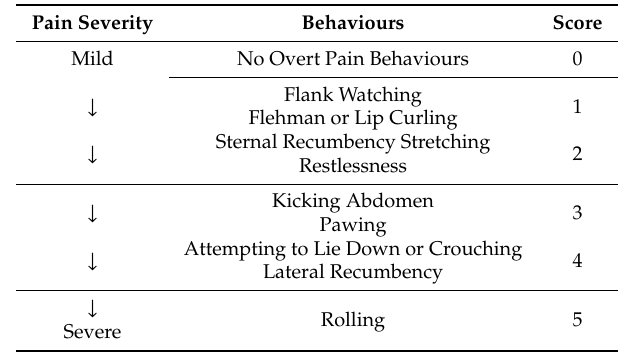
Table 1. The Equine Acute Abdominal Pain Scale. A pain severity score is given based on the score of the behaviour demonstrated. If two or more behaviours are demonstrated, then the score is assigned based on the behaviour with the highest